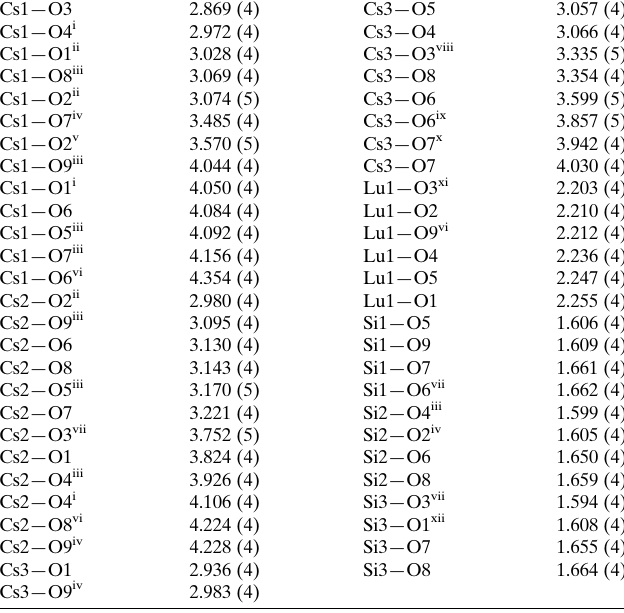
Table 1 Selected bond lengths (A˚ ).